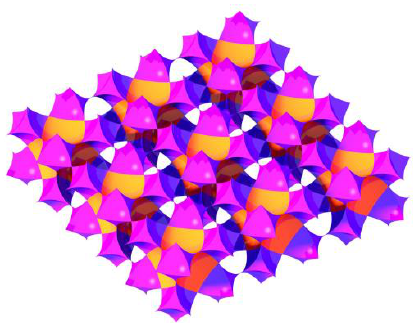
Figure 2. Interconnected octahedral (orange) and tetrahedral (purple) pores of silica colloidal crystal (SCC).